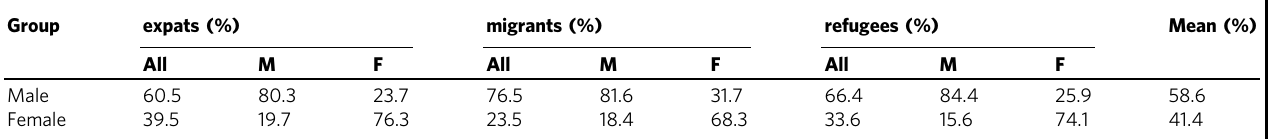
Table 2 Estimated distribution of gender in detected faces per group of interest for all locations. “ M ” stands for male, “ F ” for female, and “ All ” for the general